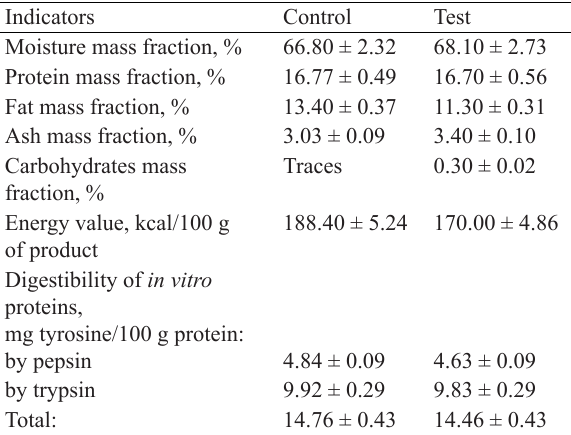
Table 5 Nutritional indicators of restructured poultry